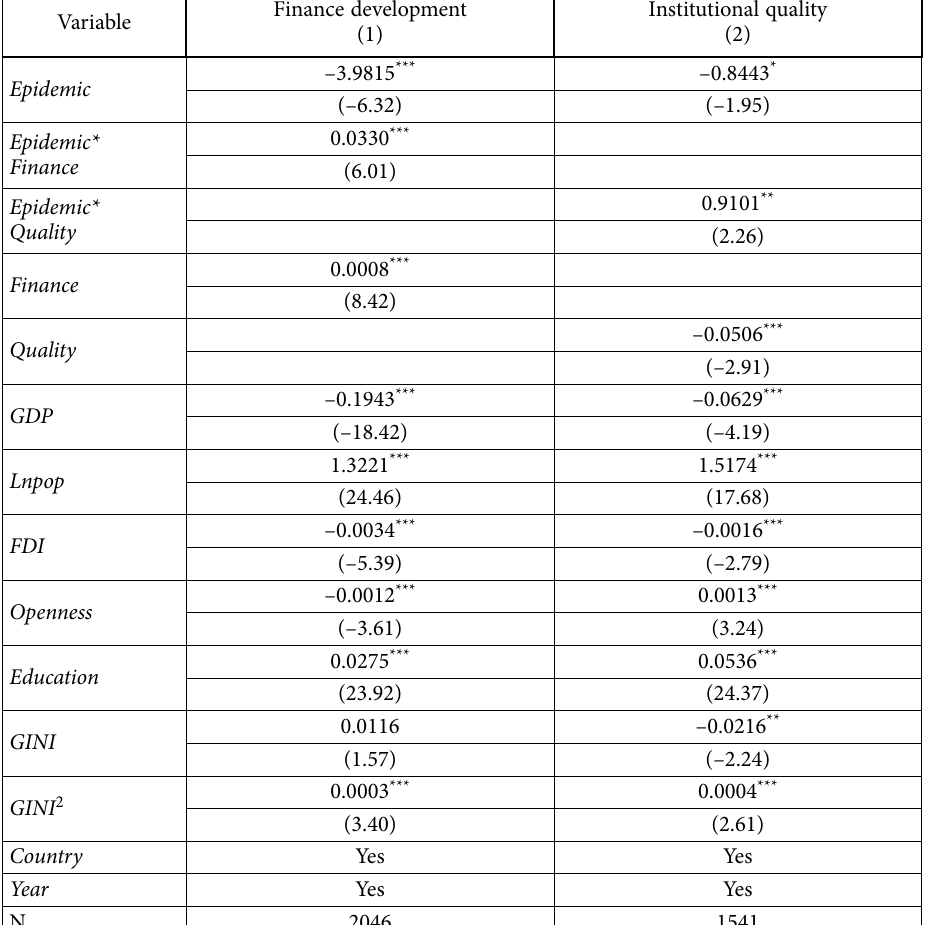
Table 4. Estimation results of mediating